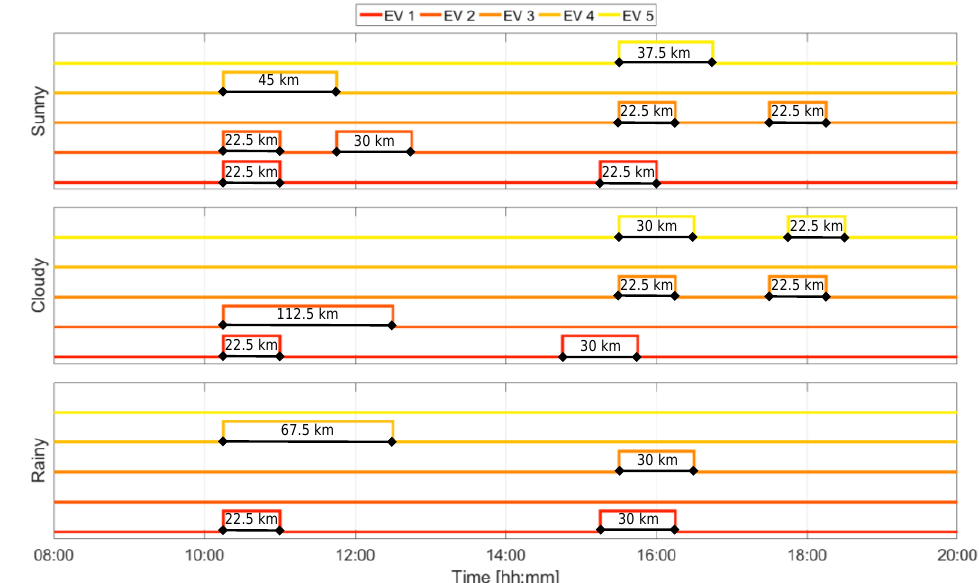
ff erent days. Appl. Sci. 2019 , 9 , x FOR PEER REVIEW